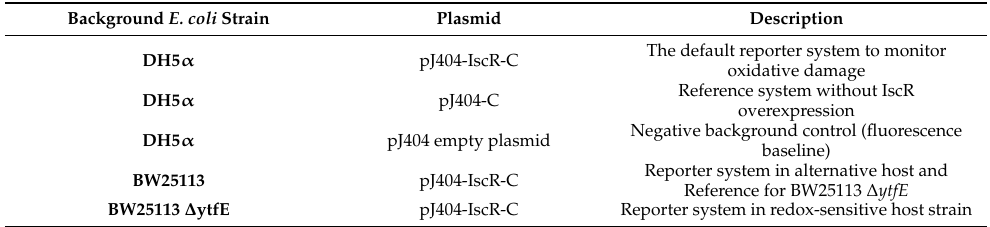
Table 1. List of the E. coli strains generated and analysed in this study. “IscR” in the plasmid name indicates IscR overexpression, while “C” refers to the gene encoding the fluorescent E2-Crimson. See Figures 1 and S1 for plasmid construct